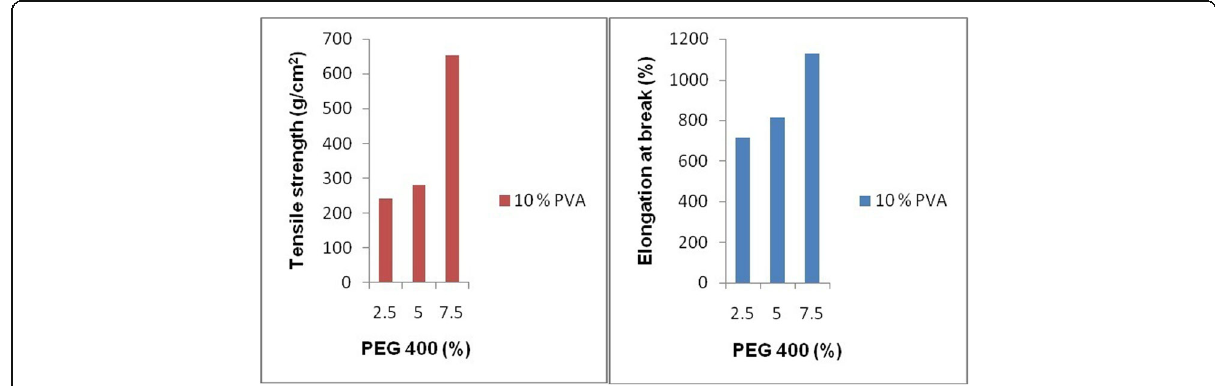
Fig. 6 Effect of concentration OF PEG 400 on the tensile strength and percentage elongation at break of the hydrogel sheets, n = 3, mean ±